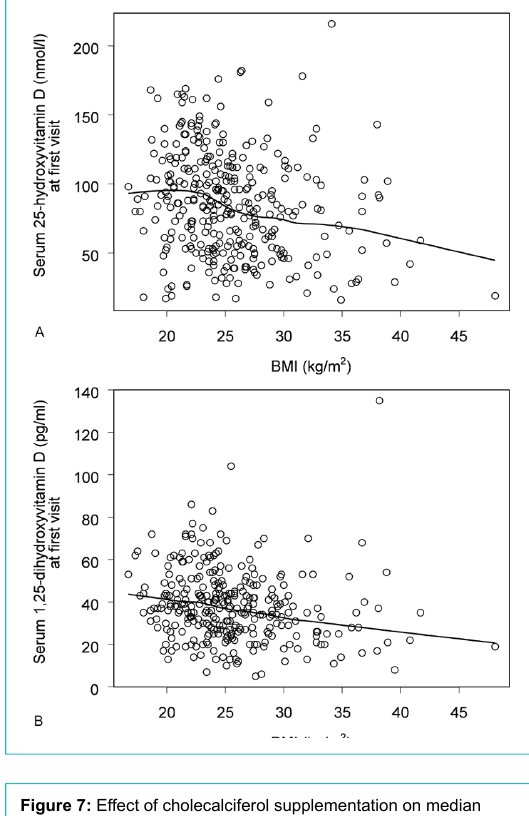
Figure 5: Correlation between 25(OH)D and 1,25(OH)2D. Note the large scattering of the data and the flattening of the trend line for 25(OH)D levels higher than 80 nmol/l.